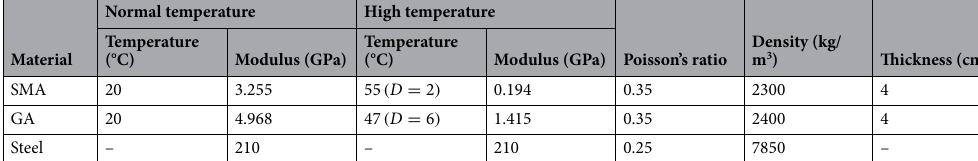
Table 1. Material properties of the steel deck and pavement. Moduli of the GA and SMA were determined at 10